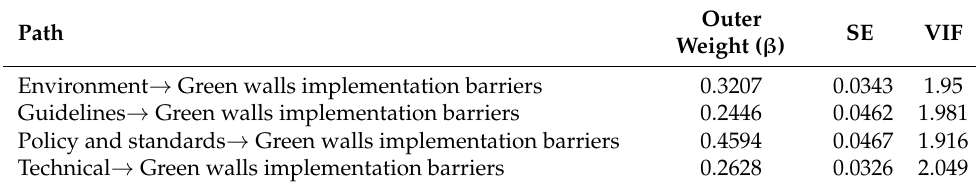
Table 7. Determinative constructs analysis. p value <